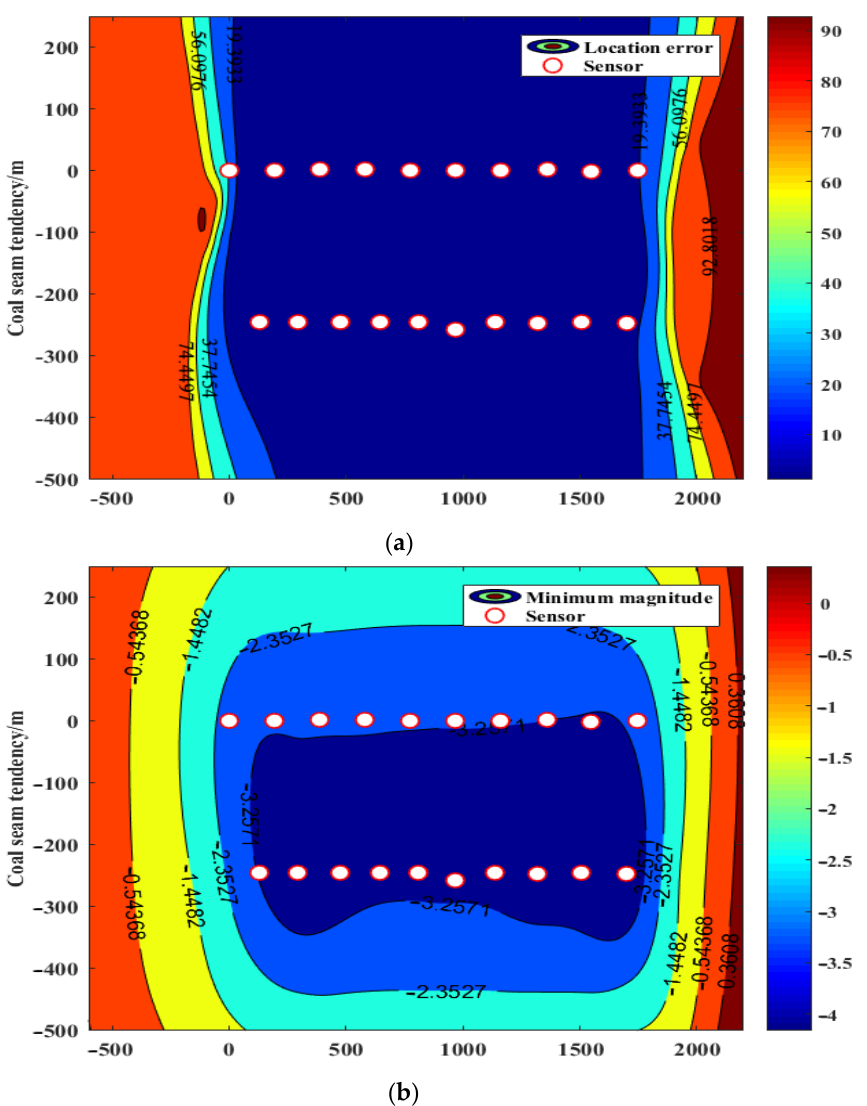
Figure 11. Evaluation of sensor arrangement on the coal seam floor (920 m). ( a ) Positioning errors. ( b ) Sensitivity.